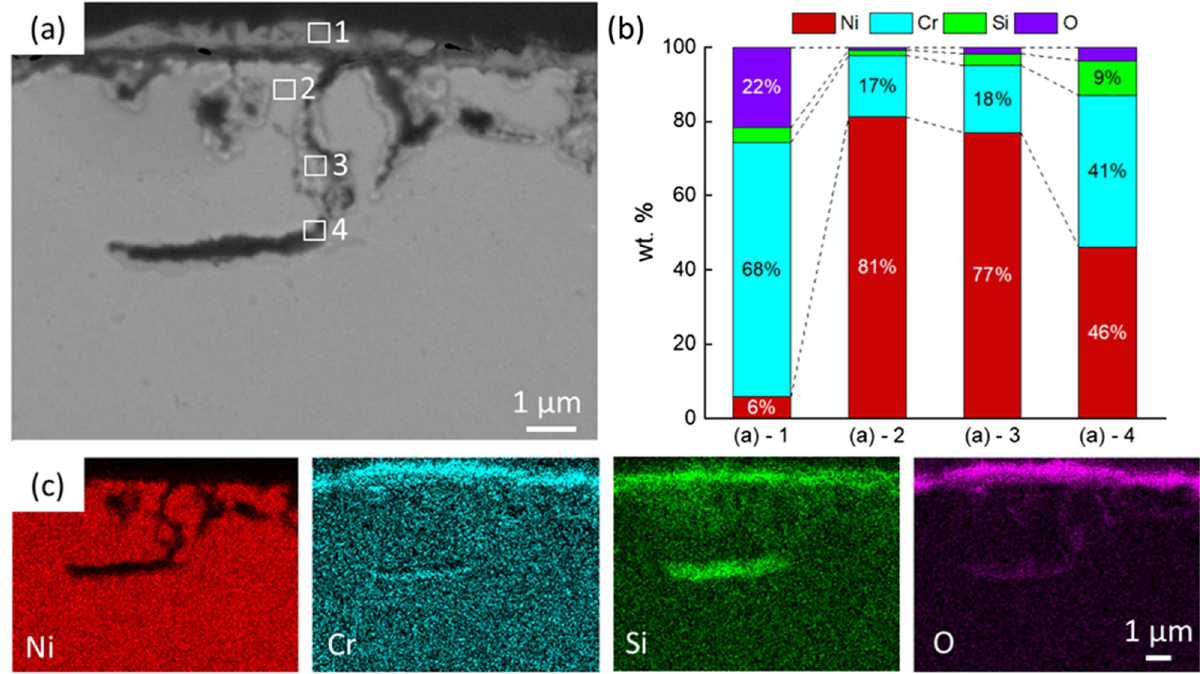
Figure 4. Morphological and elemental analysis of Ni–20Cr corrosion in KCl–NaCl in air for 16 h: ( a ) Cross- sectional SEM image, ( b ) elemental analysis by EDS, ( c ) element mapping by EDX showing the elemental